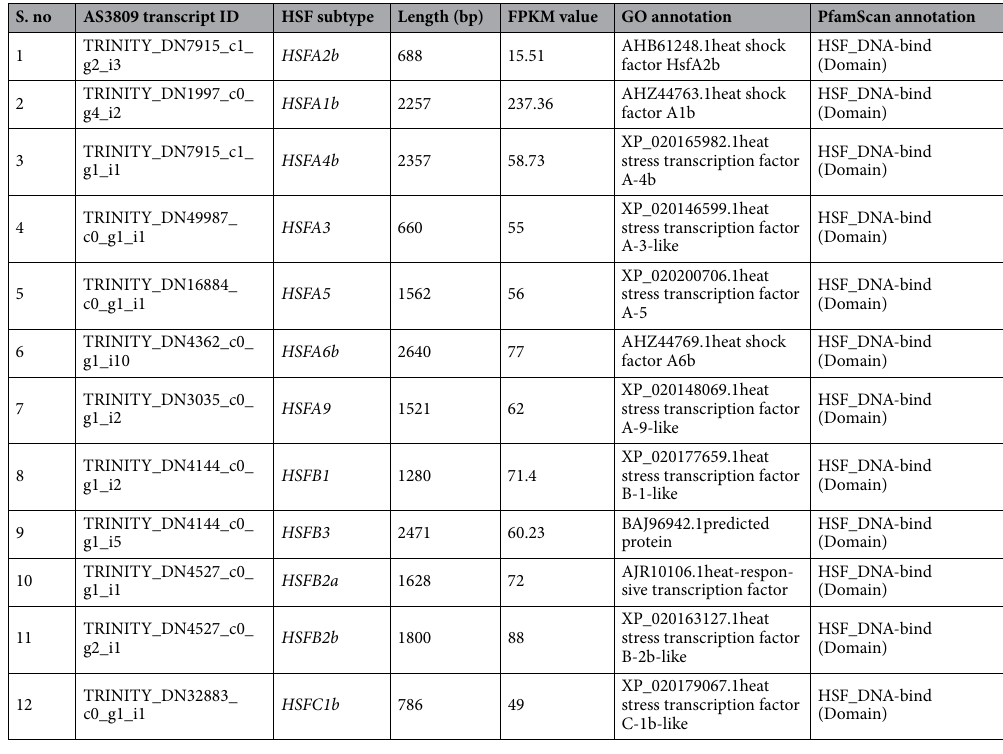
Table 4. List of Trinity IDs of 12 HSFs selected from Aegilops speltoides acc. pau3809 transcriptome assembly with maximum FPKM value along with their GO annotation.